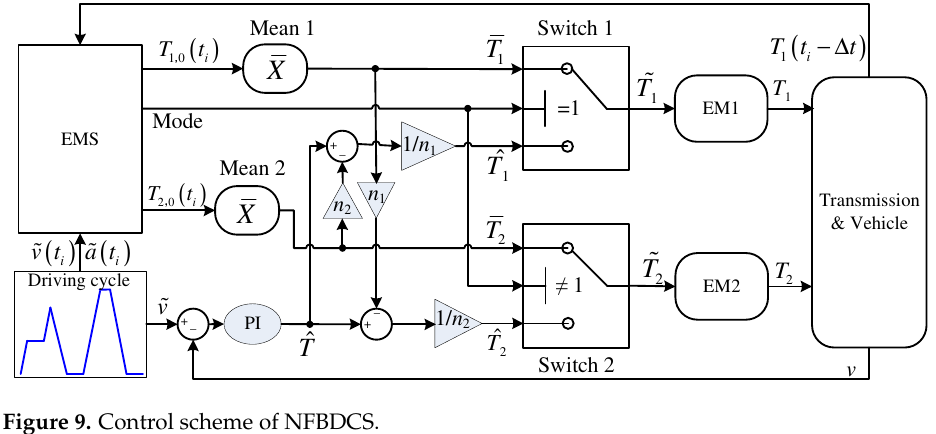
Figure 9. Control scheme of NFBDCS.